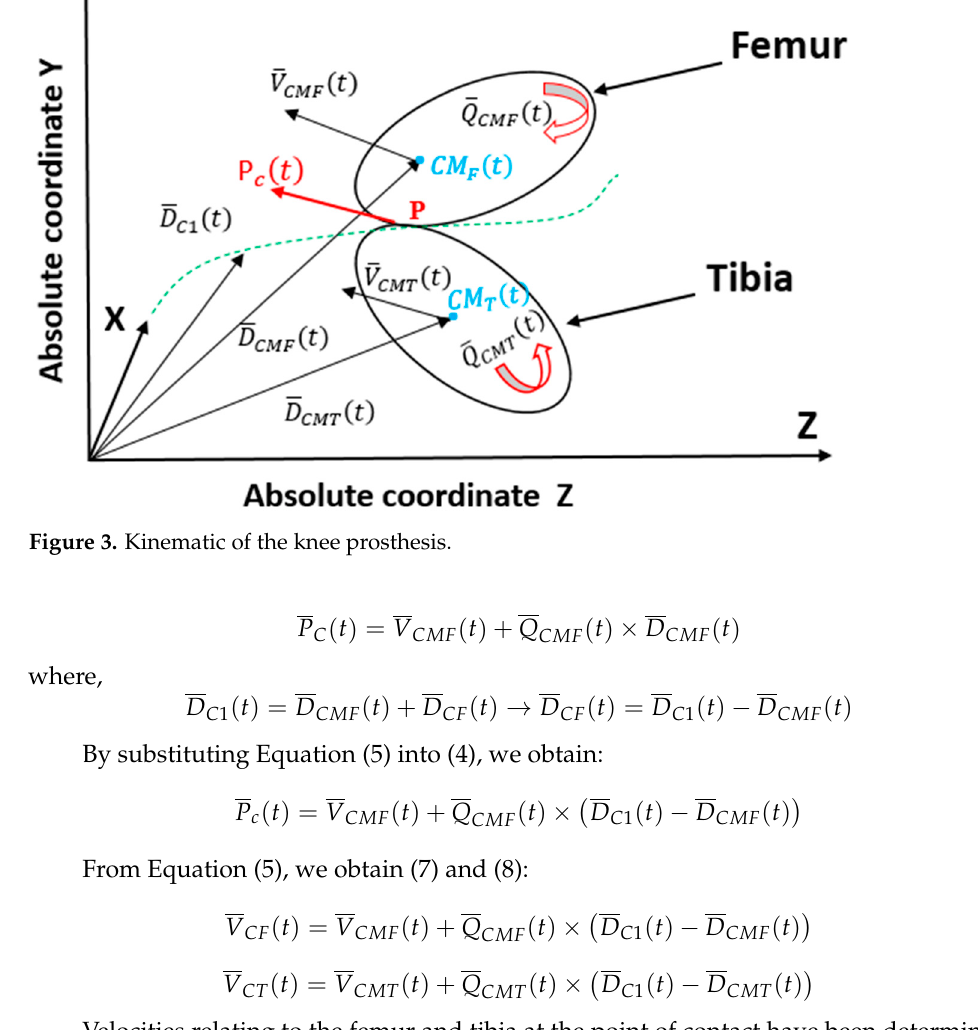
Velocities relating to the femur and tibia at the point of contact have been determined in the absolute coordinate system (Figure